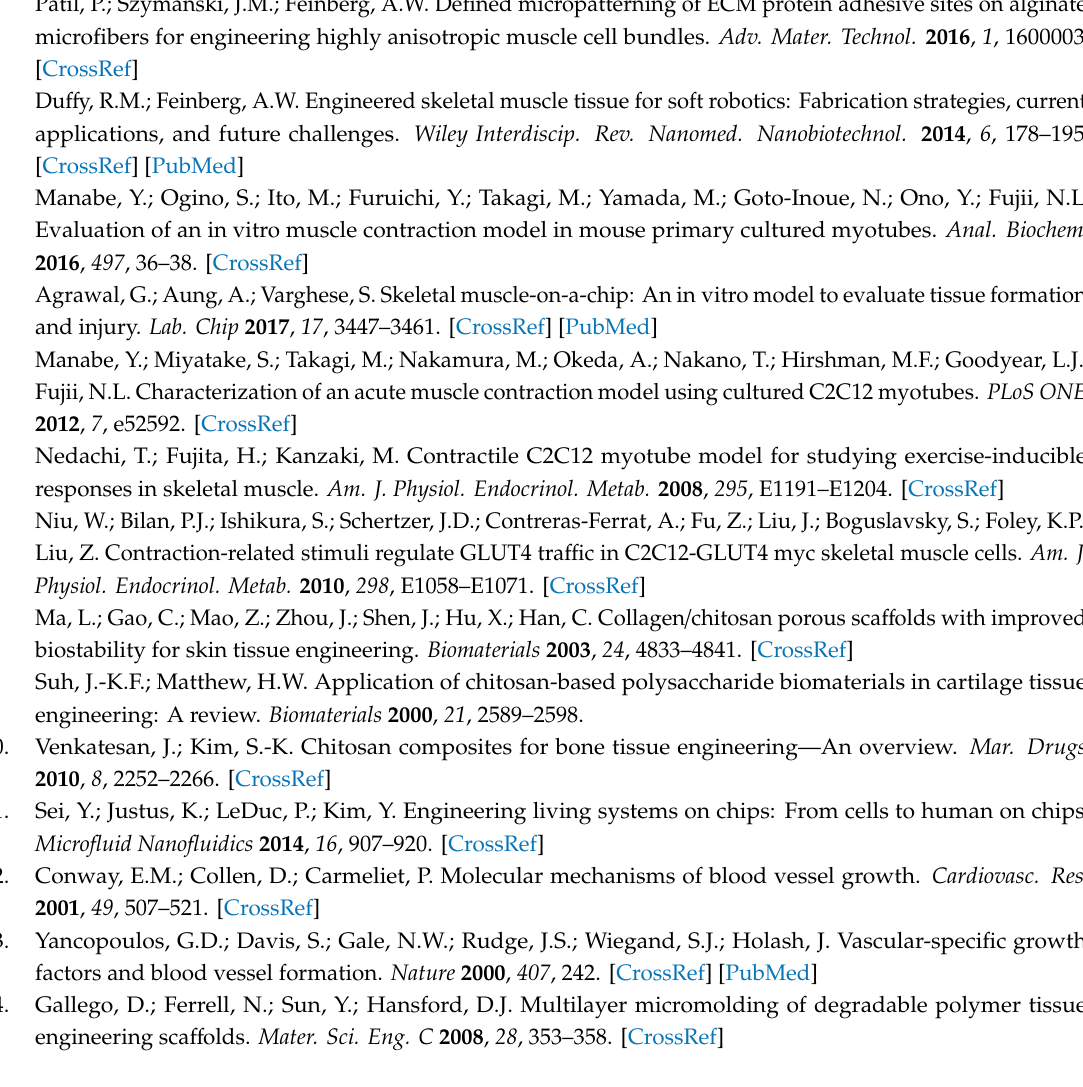
Figure S1: C2C12 cells cultured in the microfluidic channel ECM sca ff olding system for up to 7 days. Figure S2: C2C12 cells cultured in a 3D sca ff old for 6 days with DMEM + 2%HS. Figure S3: Schematic of the fabrication of the PDMS chamber for ECM embedding. Figure S4: Cell alignment in the ECM without the channel. Video S1: Rotational view of Figure 3E. Co-culture system for C2C12 cells in 3D sca ff old with HUVEC cells cultured in the channel (lower half of the channel). HUVEC cells attached to the channel wall and formed a curved distribution along the circular channel wall. Video S2: 3D rotational view of C2C12 cells in 3D at day 1. Video S3: 3D rotational view of C2C12 cells in 3D at day 3. Video S4: 3D rotational view of C2C12 cells in 3D at day